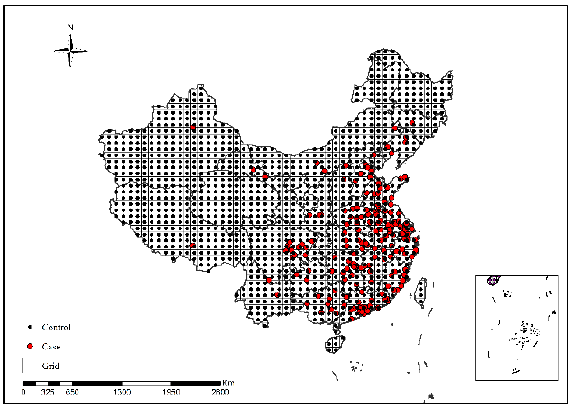
Figure 1. Sample collection